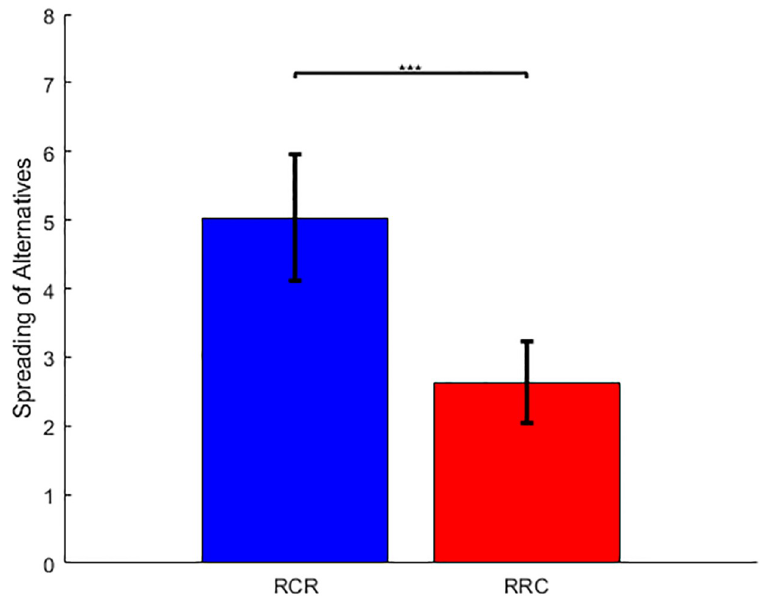
Fig 3. Comparison of RCR and RRC groups. The mean spreading of alternatives (SoA = [rating#2-rating#1] chosen — [rating#2-rating#1] unchosen ) is shown for both the RCR (blue) and the RRC (red) group. Error bars depict 95% confidence intervals. This reproduces the results of Chen and Risen (2010).